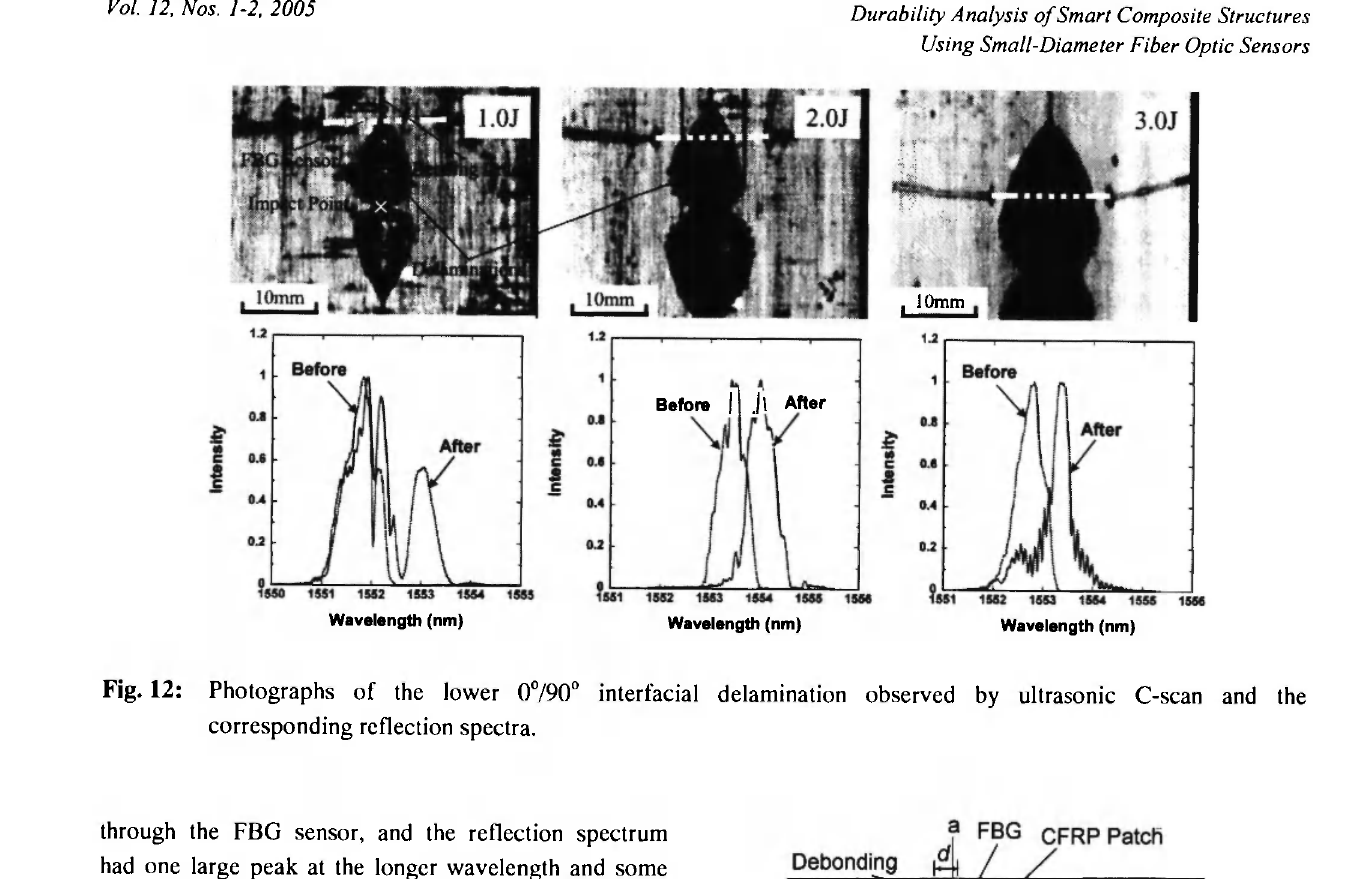
Fig. 12: Photographs of the lower 0°/90° interfacial delamination observed by ultrasonic C-scan and the corresponding reflection spectra.